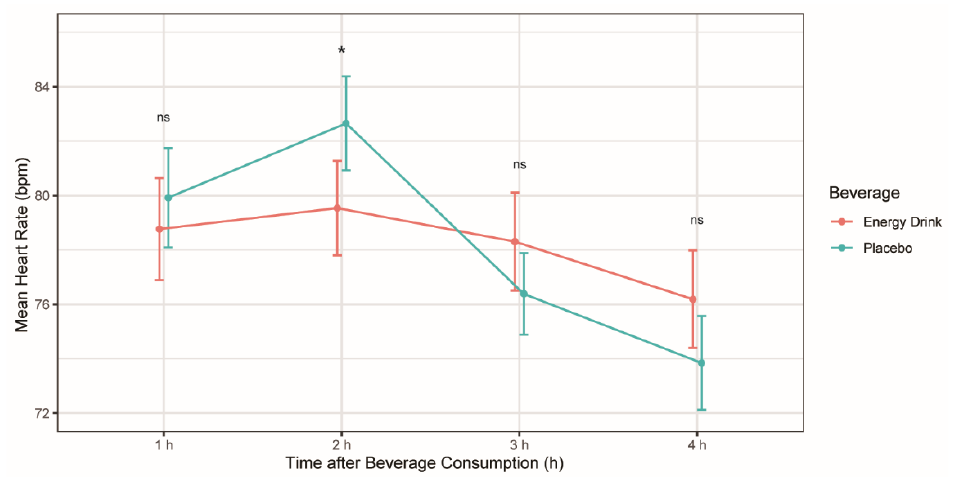
Figure 2. Mean heart rate (bpm) after energy drink and placebo consumption at different time periods. *p < 0,05, ns: no significant difference